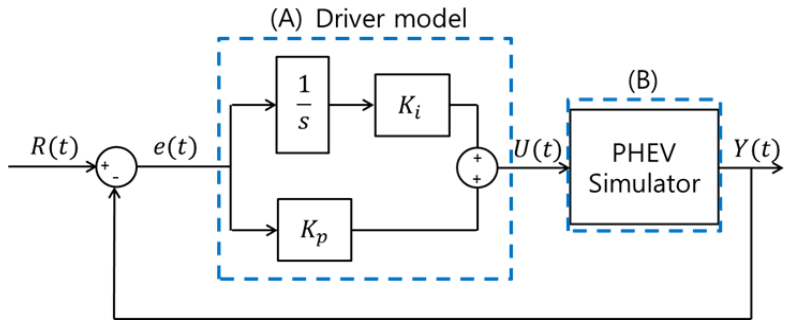
Figure 6. Block diagram of the overall